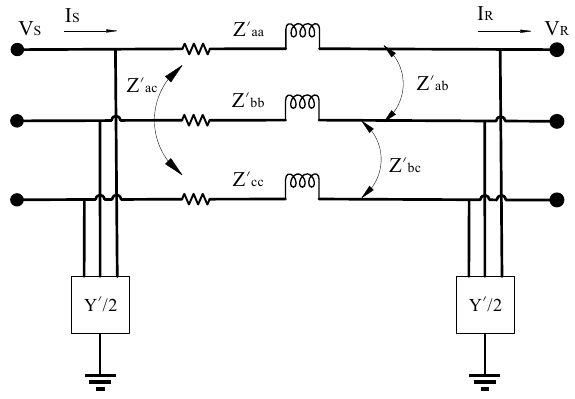
Figure 2. Distributed line parameter model of each network’s section.